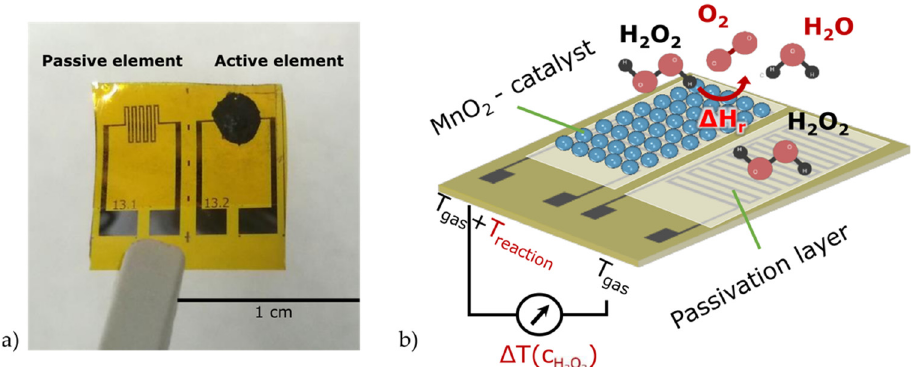
Figure 2. ( a ) A photo of the flexible calorimetric gas sensor with the passive and activated (with MnO 2 ) temperature elements. ( b ) The schematically presented exothermic reaction of the H 2 O 2 with MnO 2 on the active sensor surface.